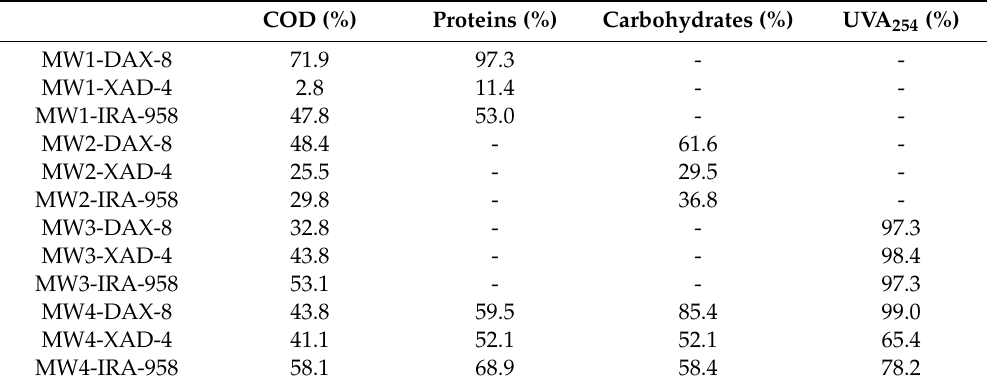
Table 2. Removal percentage of COD, proteins, carbohydrates and humic acid (through UVA 254 ) from the model waters by adsorption with the used